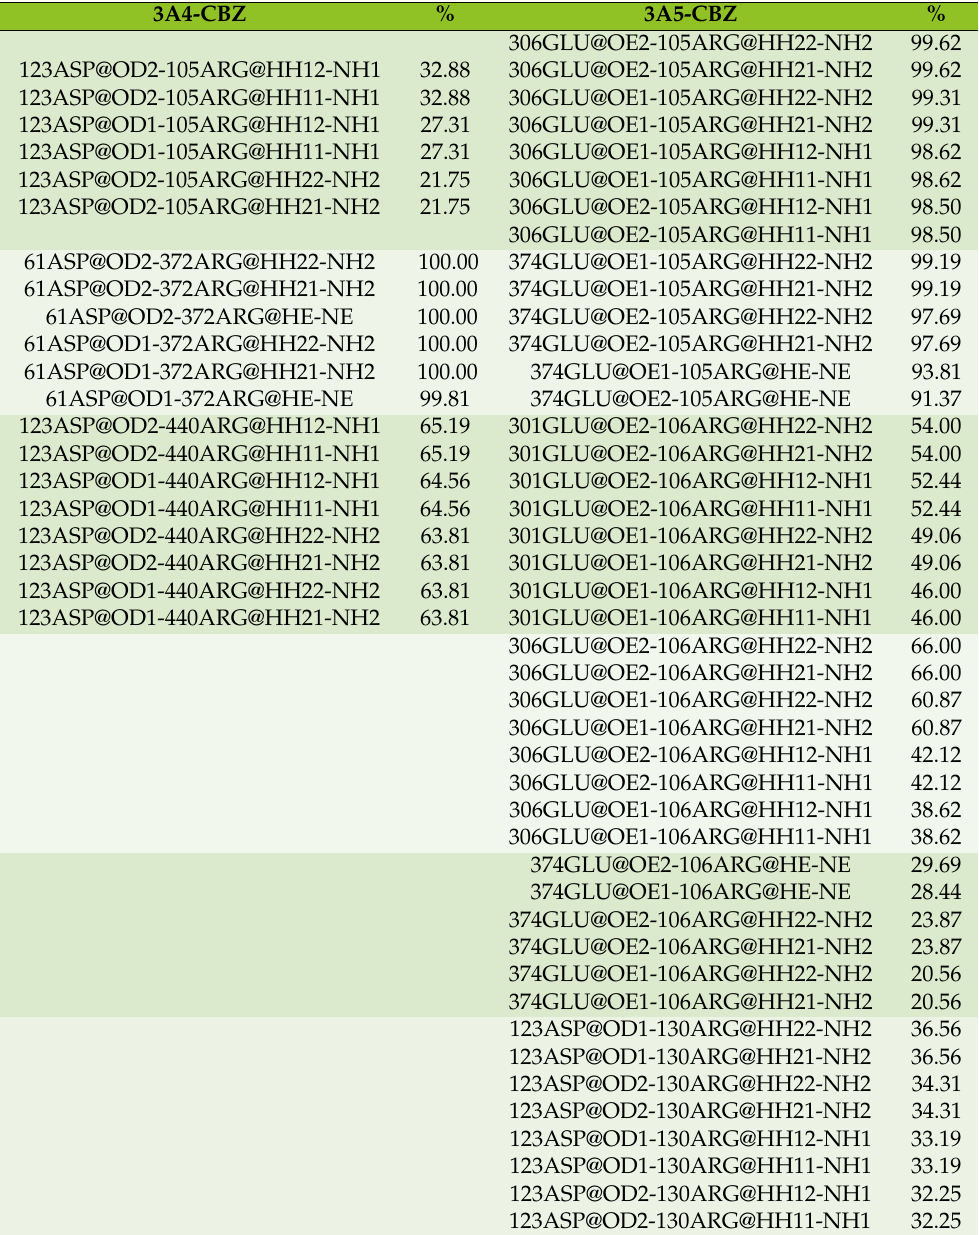
Table 2. Salt bridge analysis in the complex